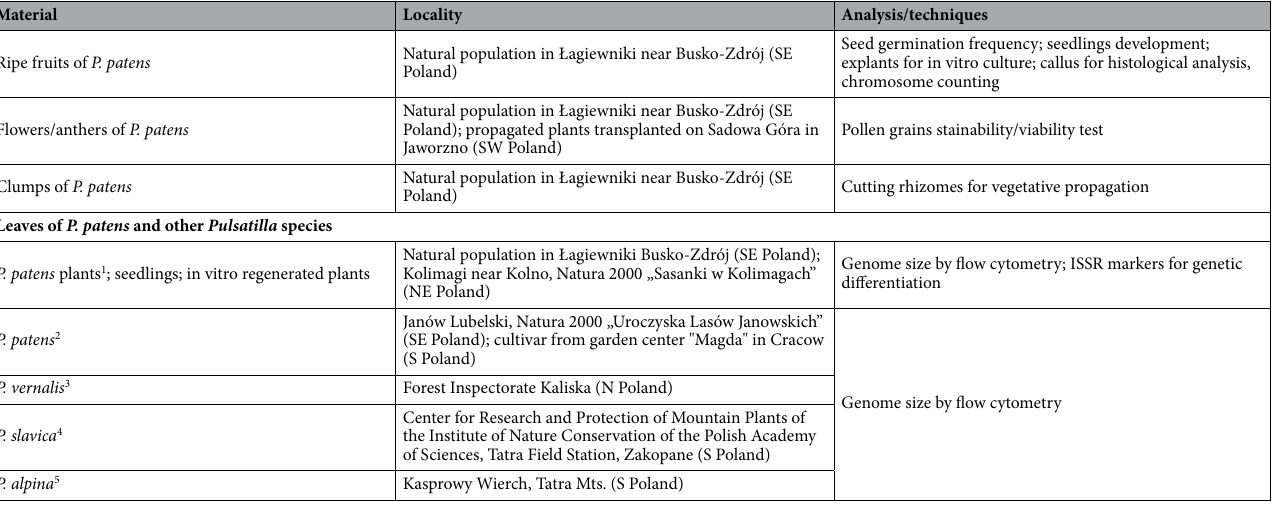
Table 6. Pulsatilla species used for different analyses. 1 ,2 —Dr. Monika Jędrzejczyk-Korycińska & dr. Teresa Nowak from the University of Silesia in Katowice (Katowice, Poland). 3 —Employees of the Forest Inspectorate Kaliska. 4 —Prof. Szymon Zubek from the Jagiellonian University in Kraków (Cracow, Poland). 5 —Prof. Zbigniew Mirek from Polish Academy of Science (Cracow,